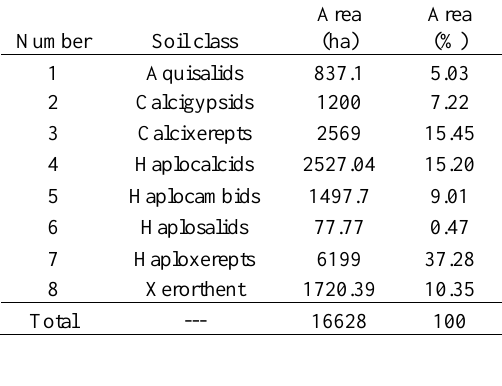
Table1: Soil great group class area